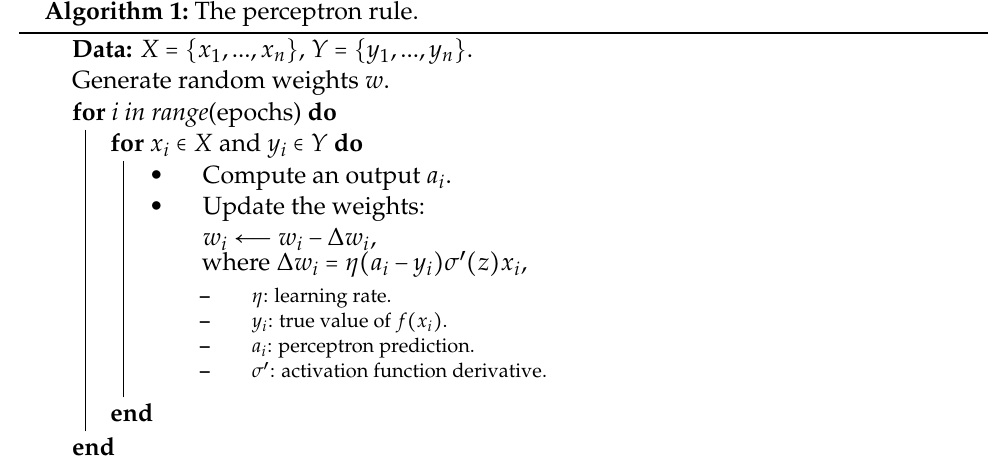
Algorithm 1: The perceptron